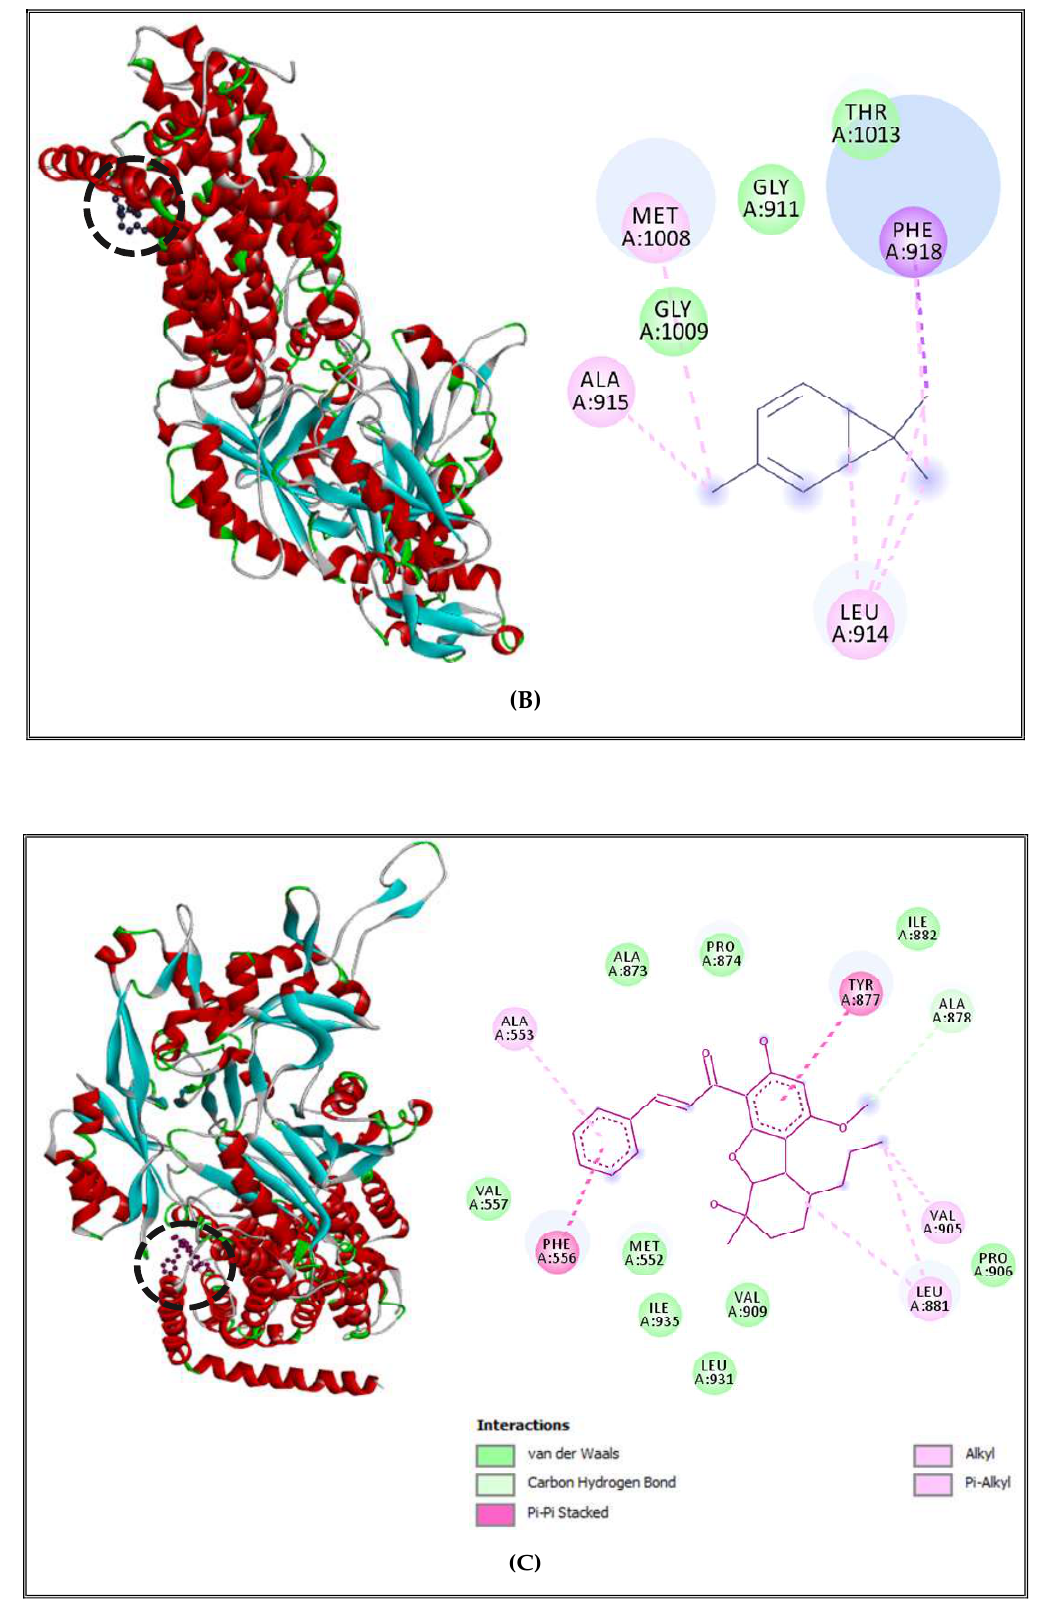
Figure 2. AcrB efflux pump receptor of S. enterica Typhimurium complexed with α-pinene ( A ), δ-3-carene ( B ), and borneol ( C )